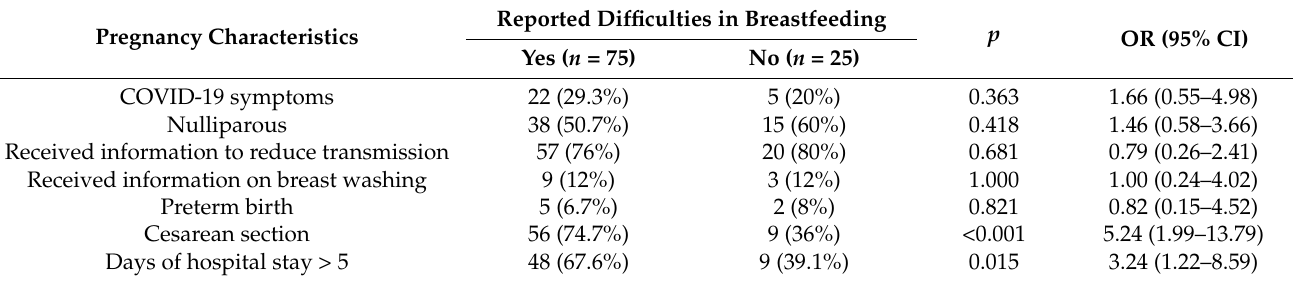
Table 3. Incidence of reported difficulties in breastfeeding and pregnancy characteristics in COVID-19 infected